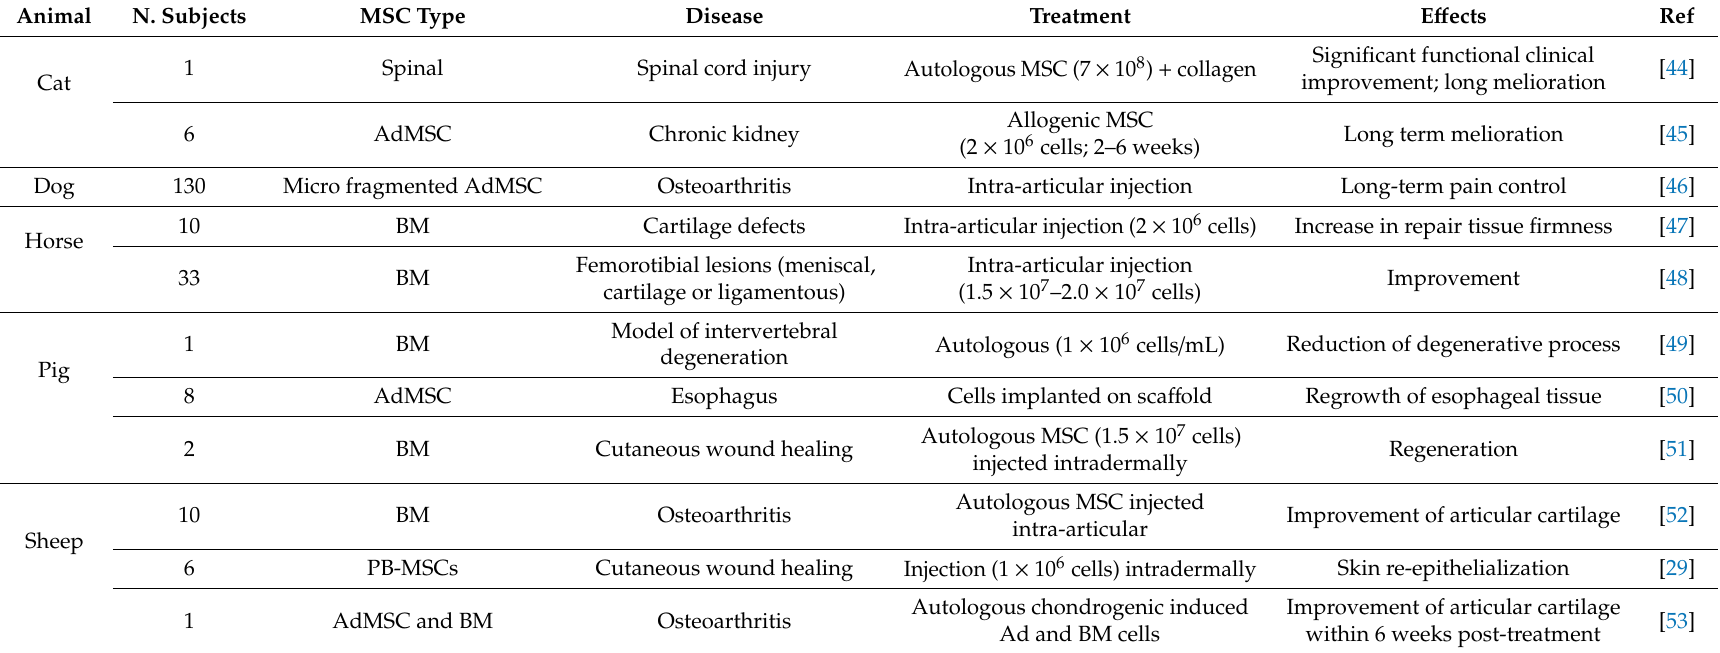
Table 2. Preclinical studies of animal-derived MSC as possible therapeutic